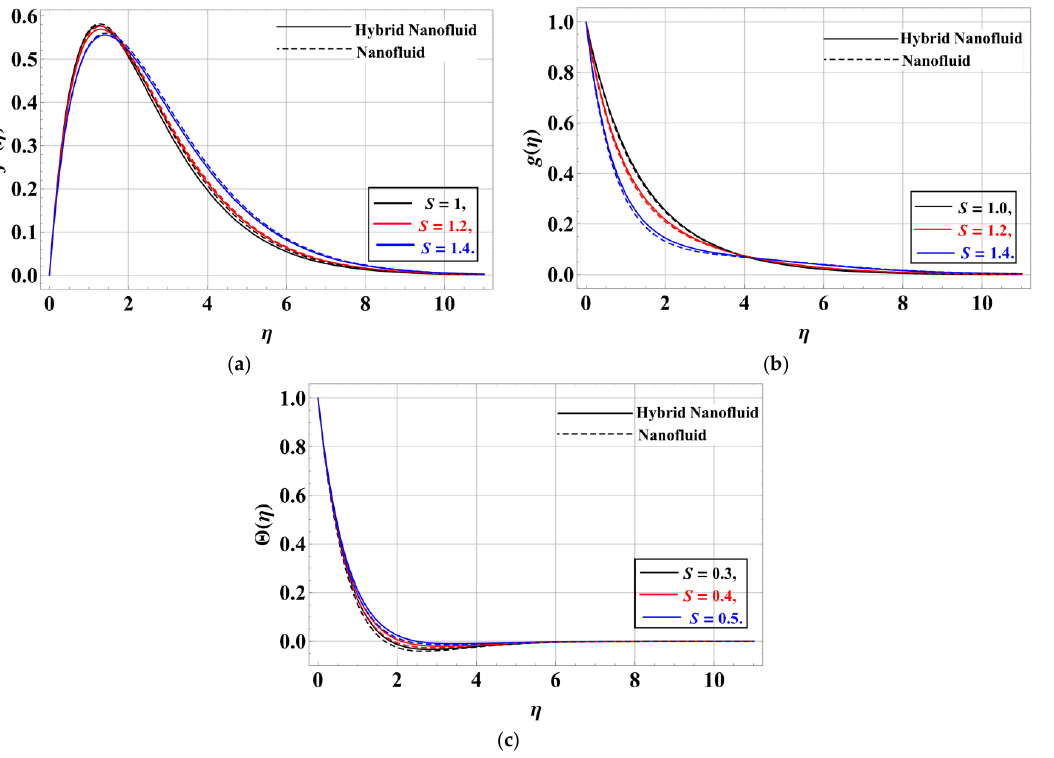
Figure 6. Variations in f (cid:48) ( η ) , g ( η ) & Θ ( η ) against S . ( a ) Variations in f (cid:48) ( η ) against S ( b ) Variations in g ( η ) against S ( c ) Variations in Θ ( η ) against S .